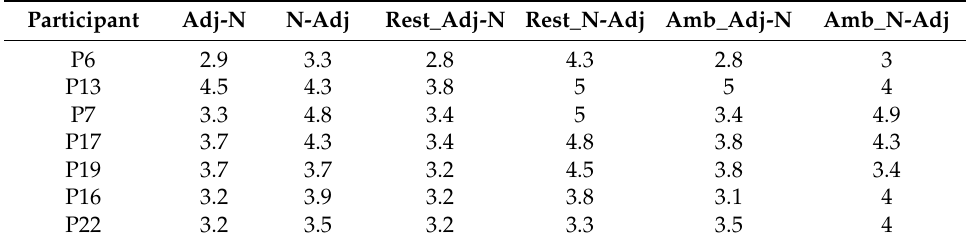
Table 1. Average ratings for participants with high ratings for restrictive postnominal adjectives. Participant Adj-N N-Adj Rest_Adj-N Rest_N-Adj Amb_Adj-N Amb_N-Adj